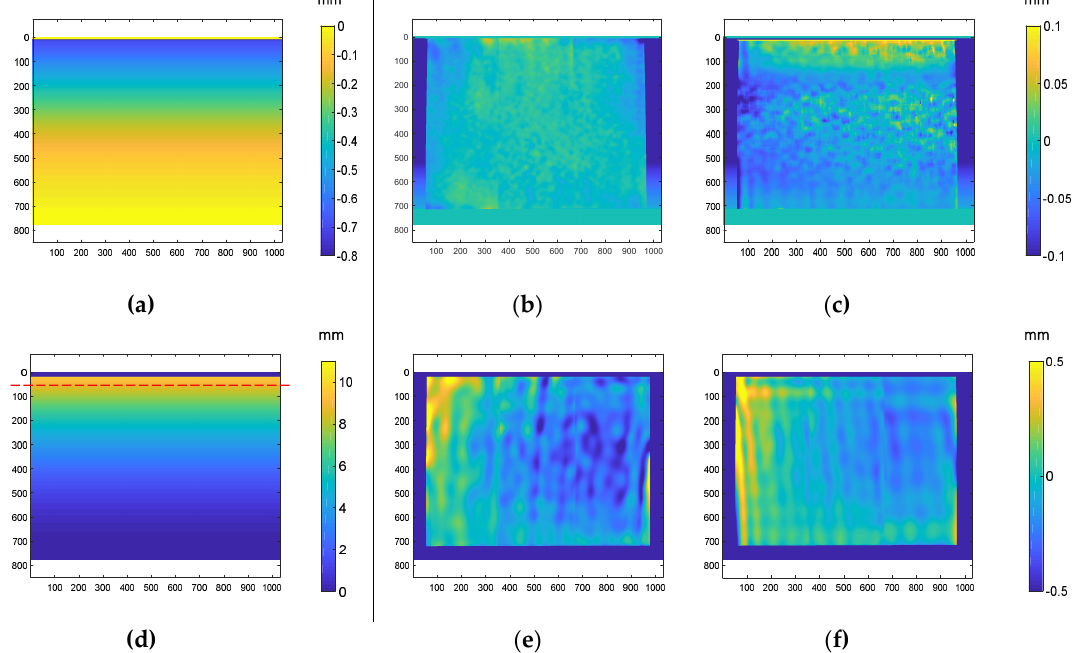
Figure 13. ( a ) Theroretical ∆ y diplacement map and differences with displacement measured employing ( b ) laser and ( c ) LCD projection. ( d ) Theoretical ∆ z displacement map and differences with displacement measured employing ( e ) laser and ( f ) LCD projection (field of view 139.4 mm × 104.8 mm).